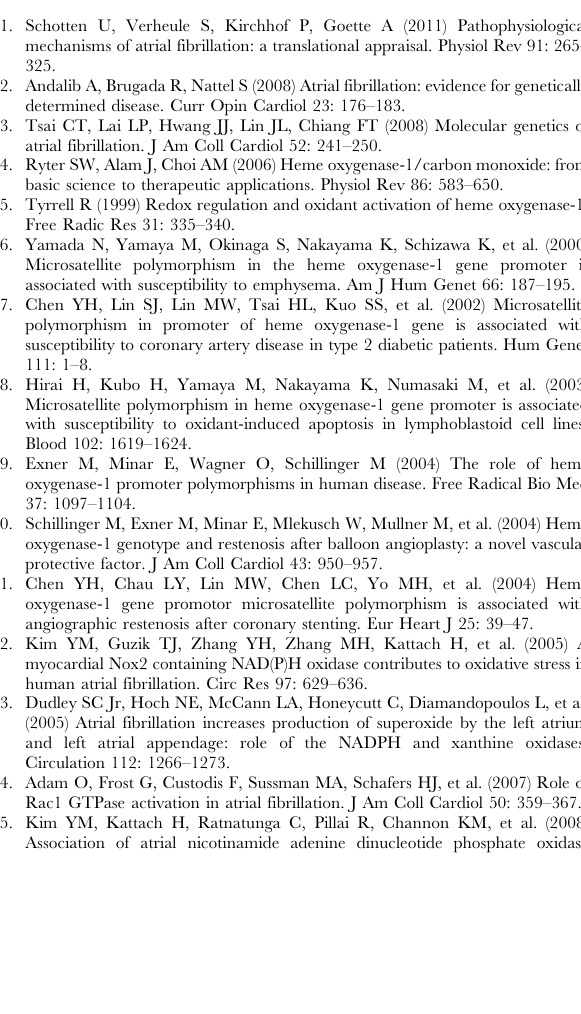
Figure S1 Frequency distribution of GT-repeats in controls (n =240) and AF patients (n=